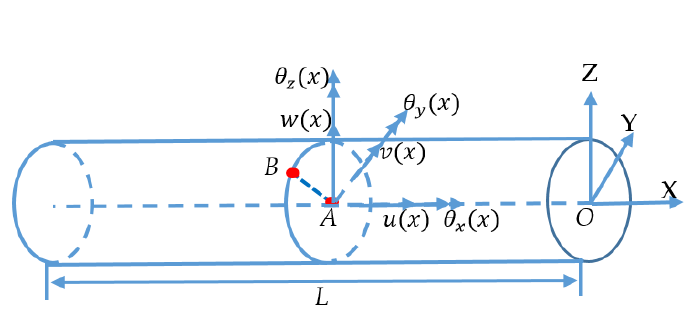
Figure 3. Beam geometry and kinematic variables.